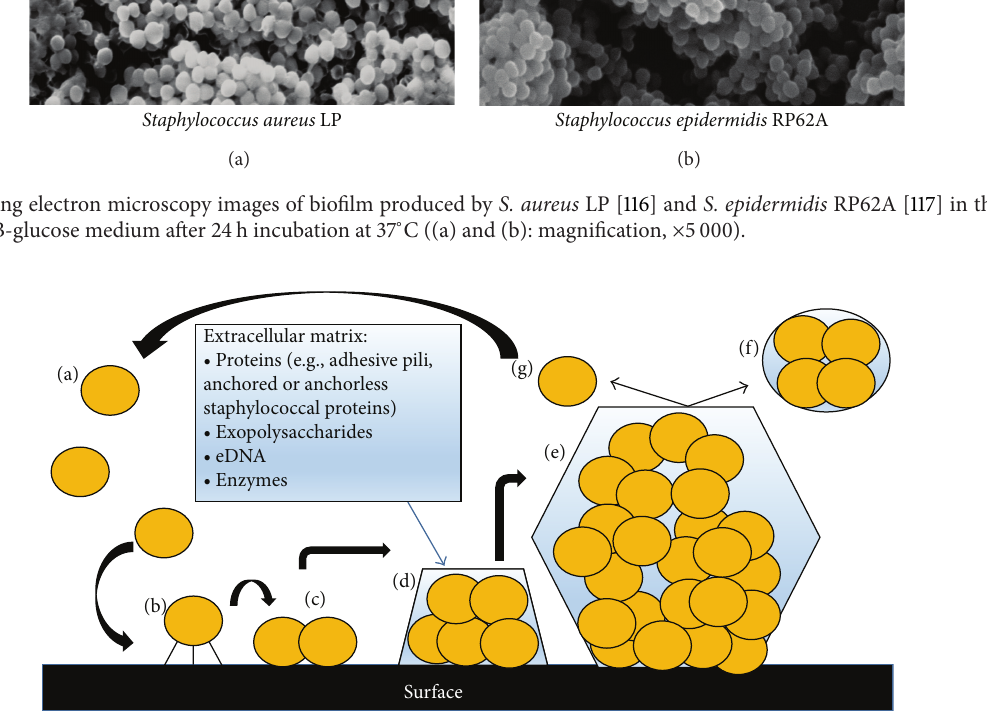
Figure 4: The different stages of biofilm formation: (a) planktonic cell; (b) reversible attachment to the surface; (c) irreversible attachment to the uncoated or protein coated surface; (d) formation of microcolonies through cell division and extracellular matrix production; (e) formation of a mature three-dimensional biofilm architecture showing pores for the passage of water. Cell detachment from the biofilm: (f) an active process leaving planktonic cell; (g) a passive process that can be shed through mechanical disruption adapted from